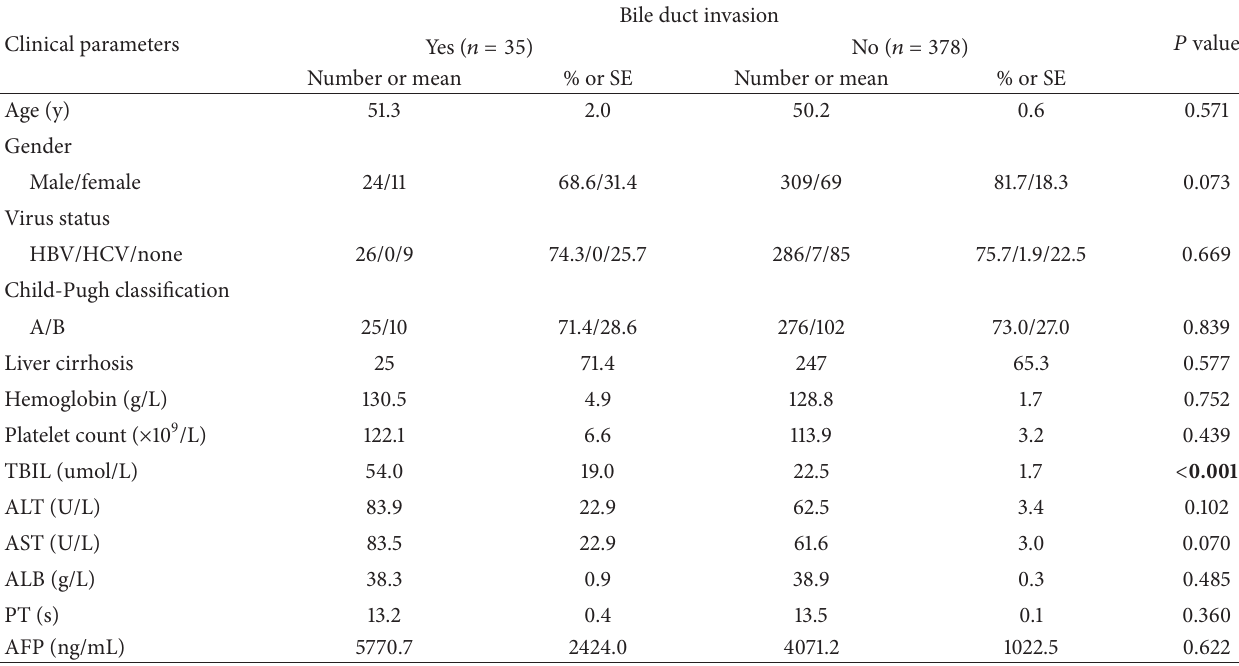
Table 1: Preoperative clinical variables of HCC patients with and without bile duct invasion. Clinical parameters